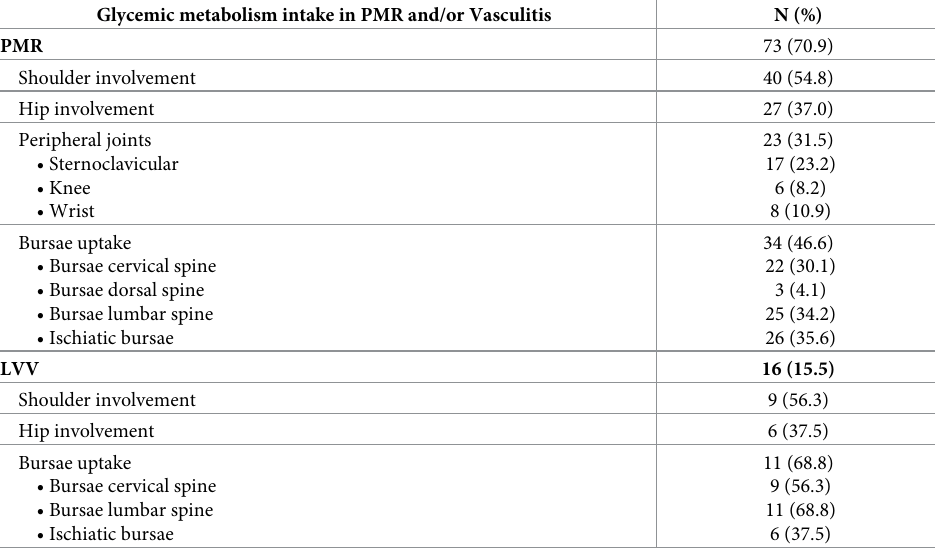
Table 3. Distribution of glycemic metabolism intake in patients diagnosed with polymyalgia rheumatica (PMR) and large vessel vasculitis (LVV). Glycemic metabolism intake in PMR and/or Vasculitis N (%) PMR 73